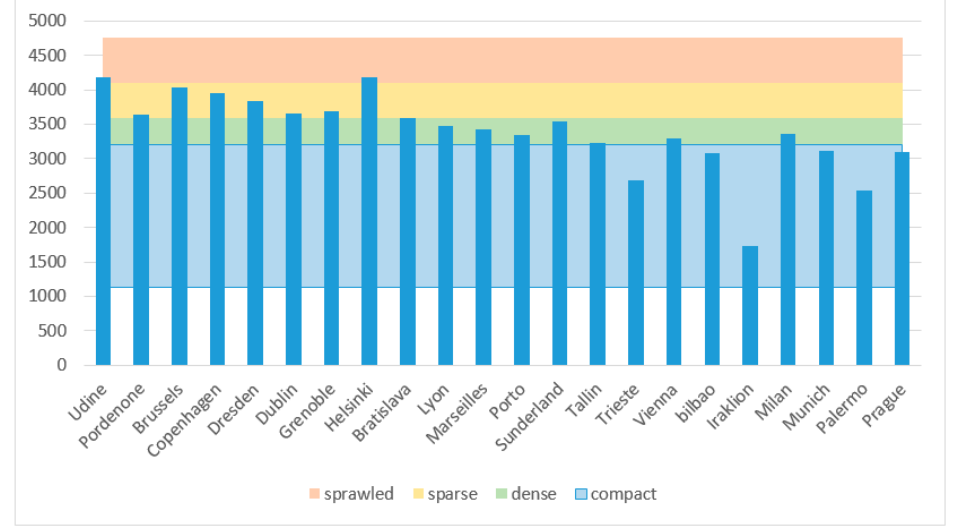
Figure 12. Classification of European cities based on their ACWUP score. Cities are placed in order of their level of sprawl based on the European Environment Agency and European Commission’s Joint Research Centre classification.